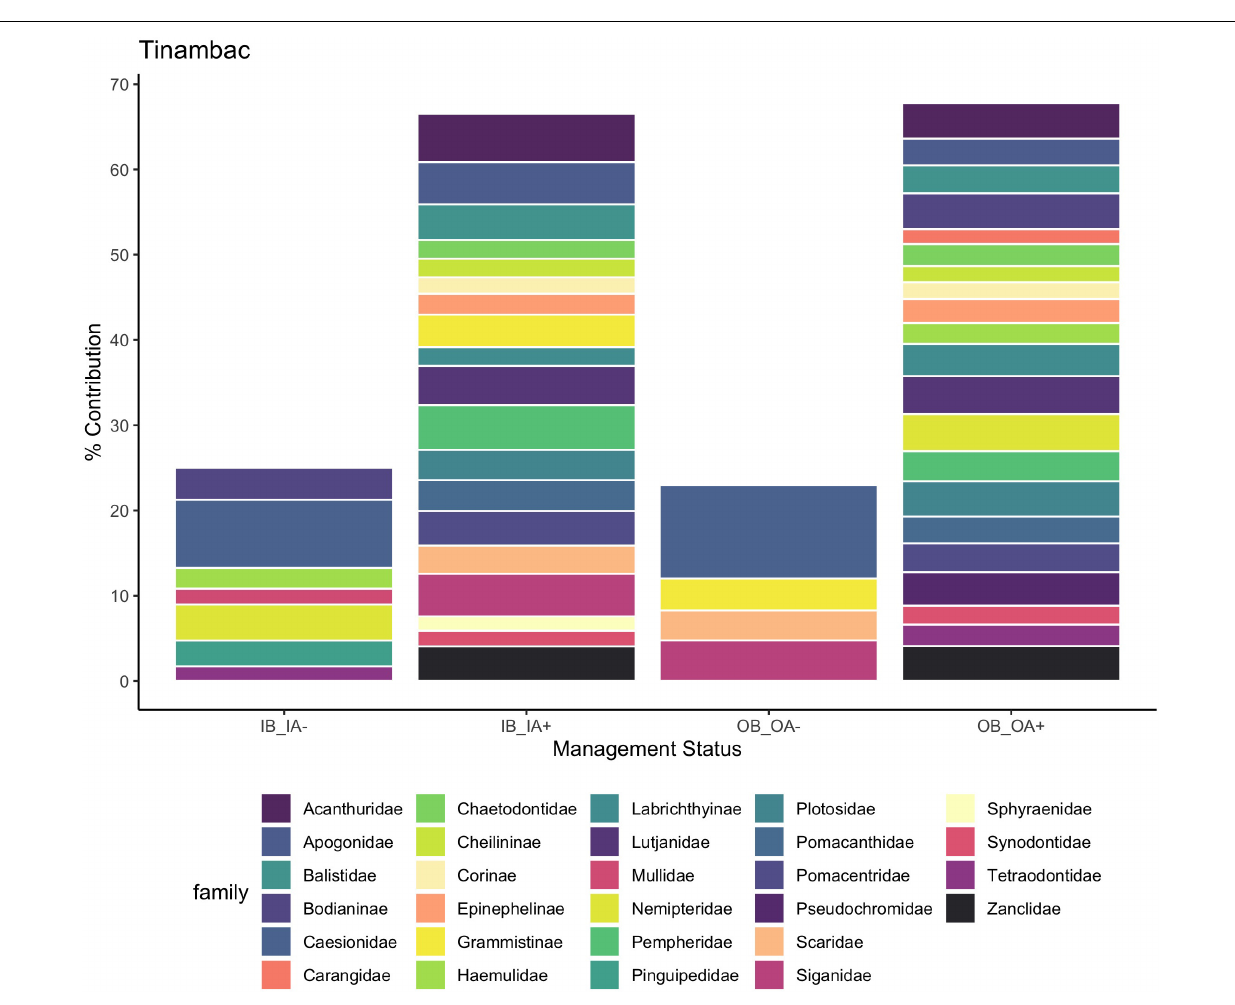
Frontiers in Marine Science |